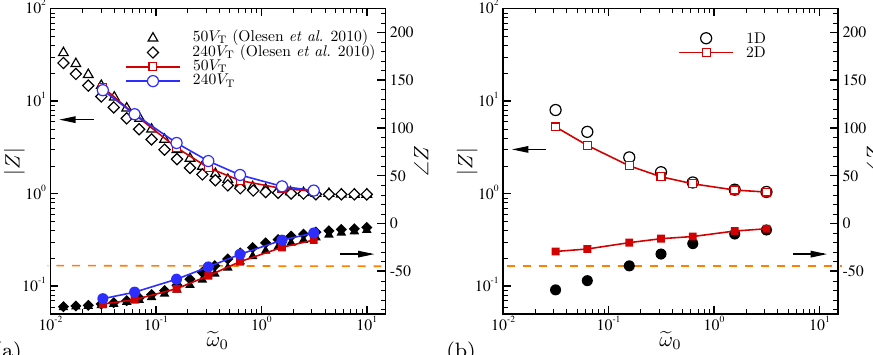
Figure 15. ( a ) The Bode plot of the overall cell impedance Z for the strictly 1D setup. To match the conditions of Olesen et al. [28], the EDL thickness is adjusted to be (cid:101) = 5 maximum AC voltages are ∆ V = 50 and 240. ( b ) The overall cell impedance for the nominal 2D setup. The horizontal dashed line corresponds to ∠ Z =